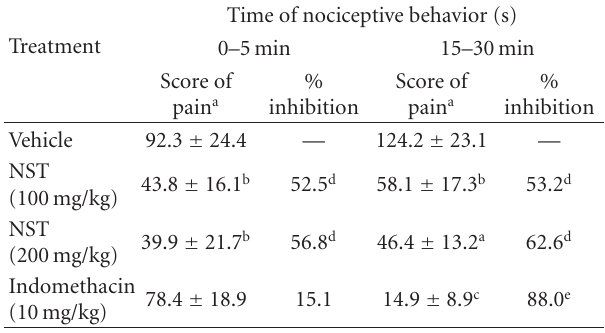
Table 2: E ff ect of NST or indomethacin on formalin-induced pain.